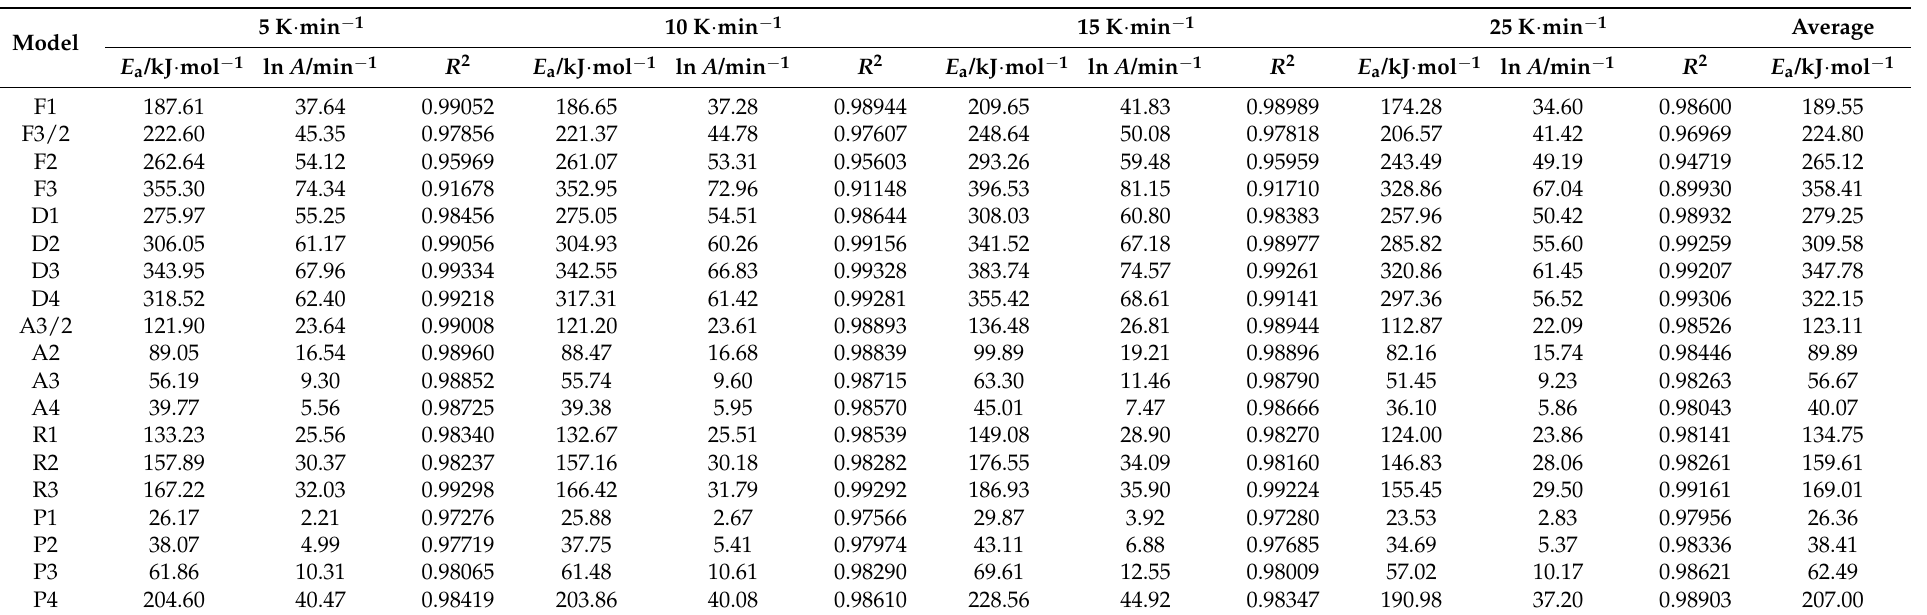
Table A3. The kinetic parameters of the first pyrolysis stage of NOC calculated by CR method at different heating